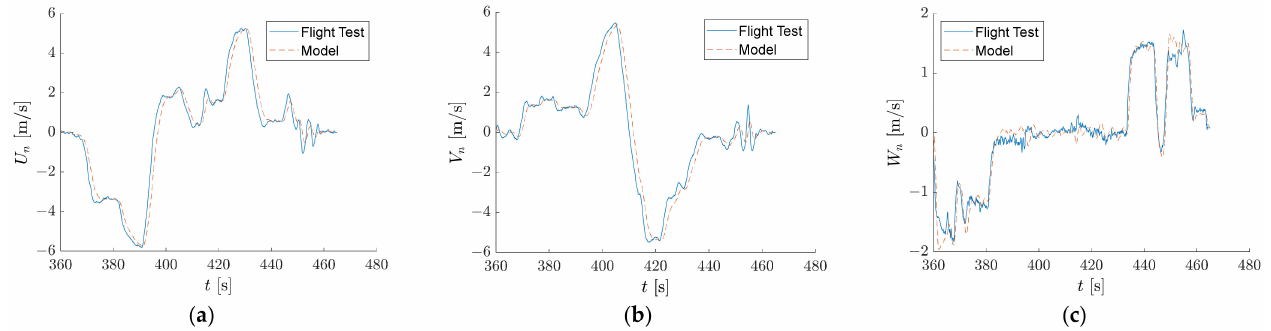
Figure 11. Linear velocities: ( a ) north–south, ( b ) west–east, and ( c ) vertical.